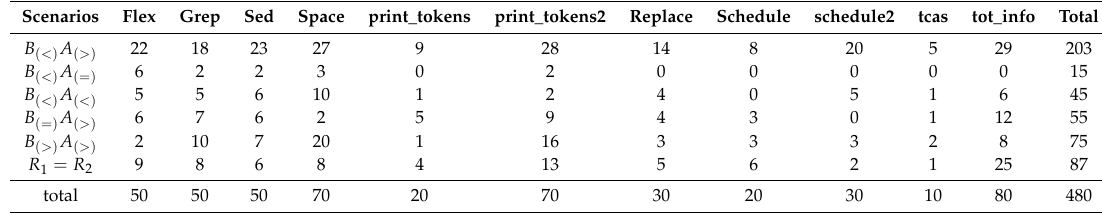
Table 6. Scenarios covered by individual subject